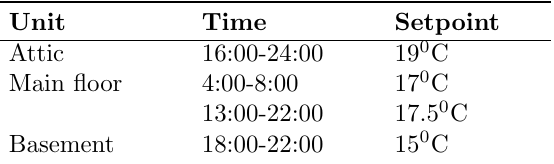
Table 2: Temperature setpoints for each floor of the building based on the time of the day